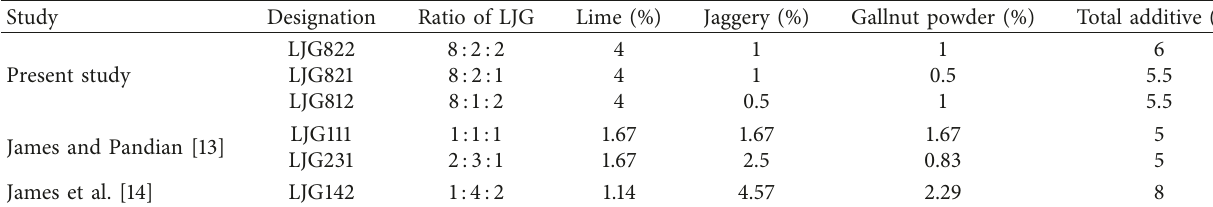
Table 3: Doses of lime and additives.